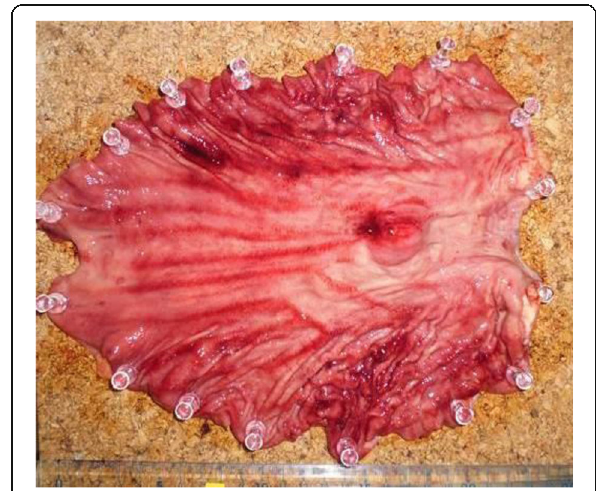
Fig. 4 Macroscopic findings of the specimen. The proximal margin of the tumor was 30 mm from the